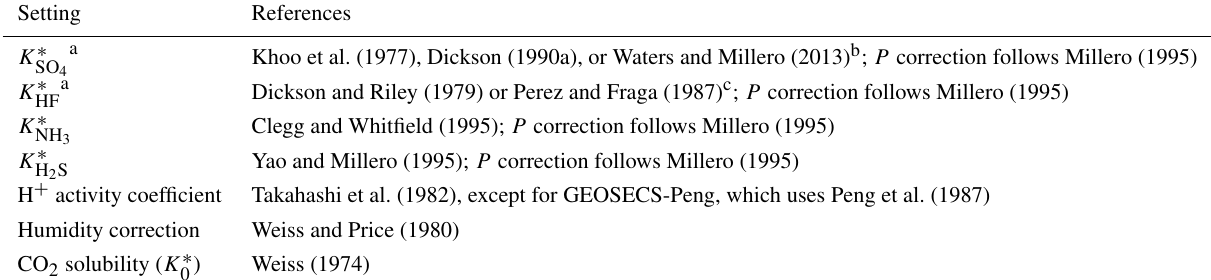
Table 3. Parameterisations that (except where noted) are not influenced by the case of the selected carbonic acid constants (Table 1).